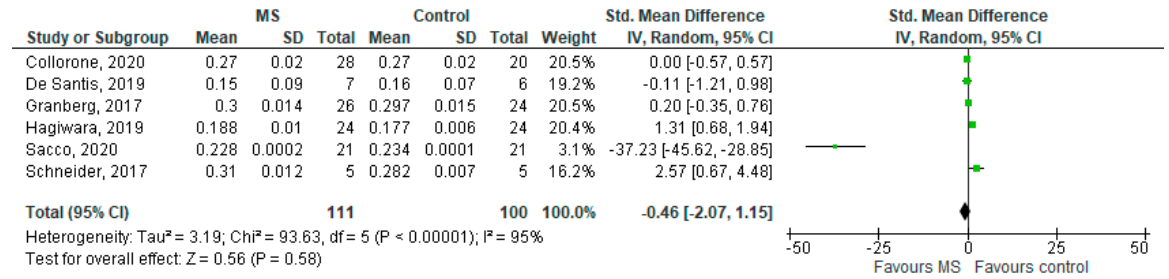
Figure 7. Forest plot for the standard mean difference of the ODI in NAWM (MS vs. control) [20,23–27]. Abbreviations: SD = standard deviation; CI = confidence interval; ODI = Orientation Dispersion Index; MS = multiple sclerosis; NAWM = normal-appearing white matter; vs. = versus; and I2 = Heterogeneity Index.